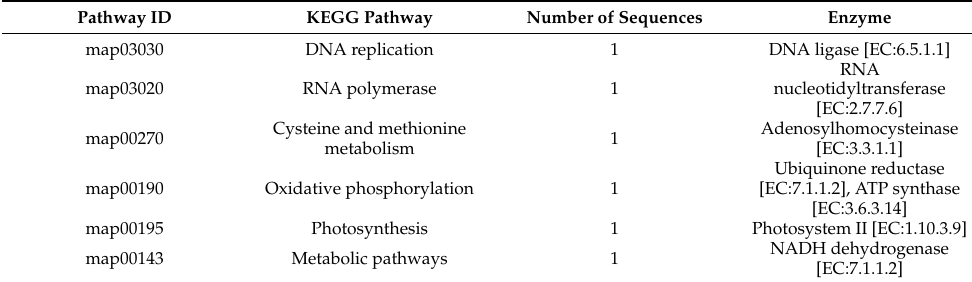
Table 1. Pathway details of annotated SNP-associated